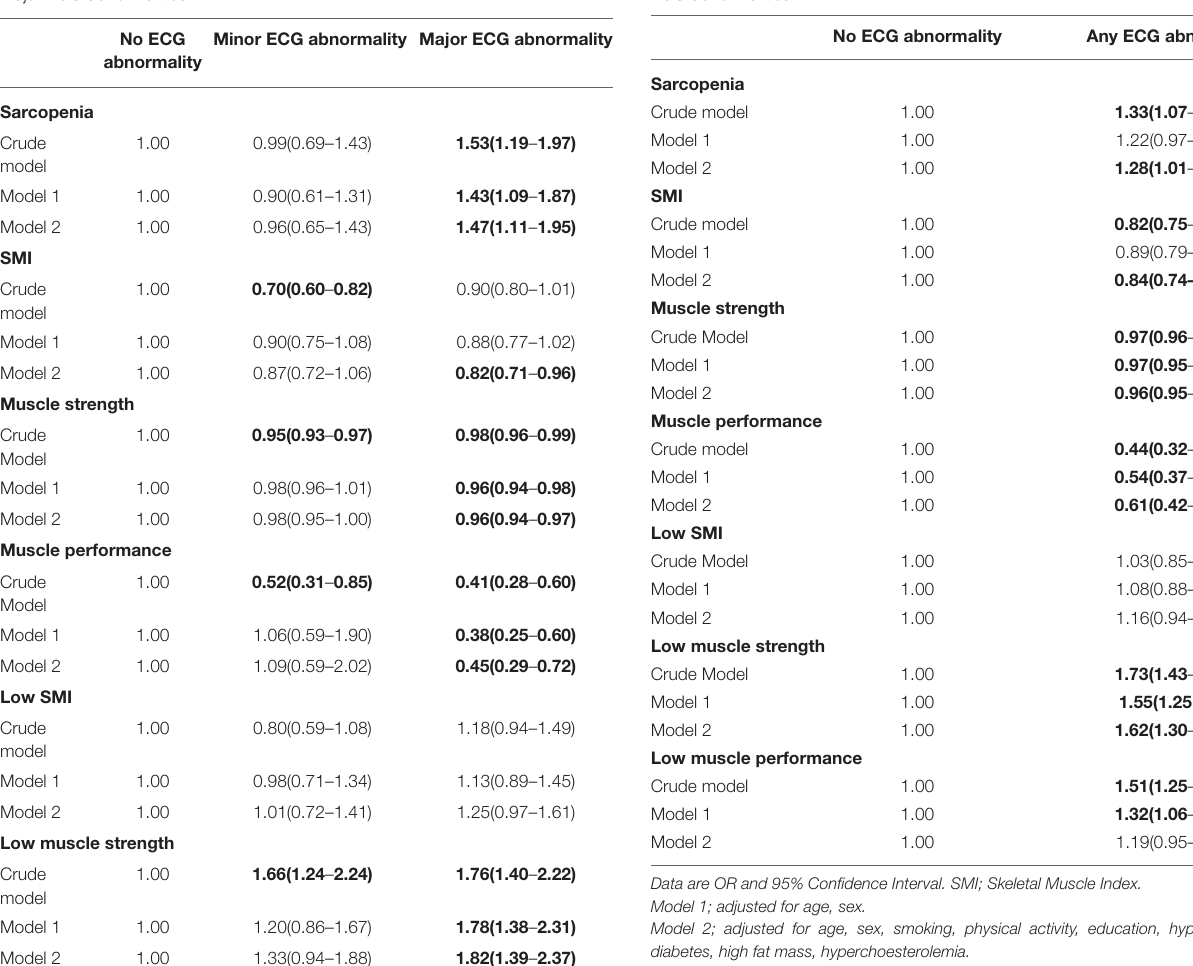
TABLE 3 | Association of sarcopenia and muscle components with any ECG